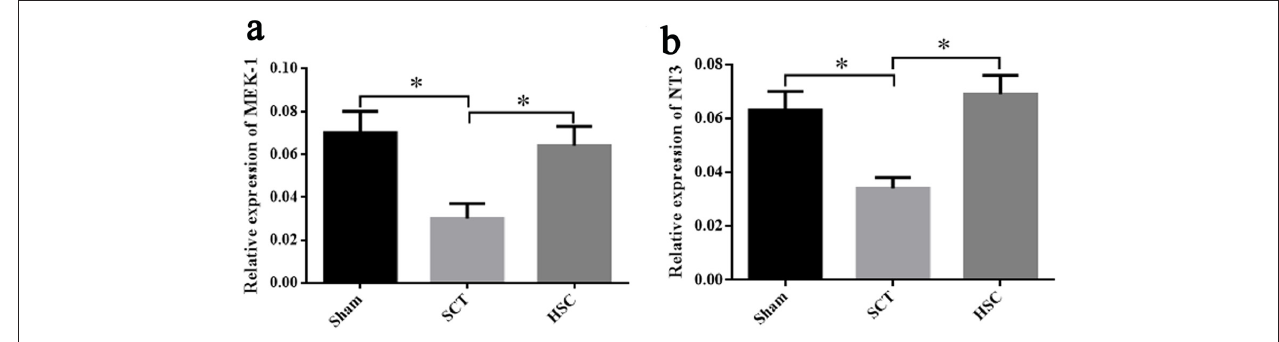
FIGURE 11 | Detection of neurotrophin-3 (NT-3) and mitogenactivated protein kinase kinase-1 (MEK-1) expression after HSC transplantation. The expressional changes of MEK-1 and NT-3 mRNA among the sham, SCT and HSC group at 24 weeks post-SCT were respectively shown in (A,B) . ∗ p < 0.05 compared with SCT group. Data are presented as the means ± SEM ( n = 8). One-way ANOVA was used to analyze the data.